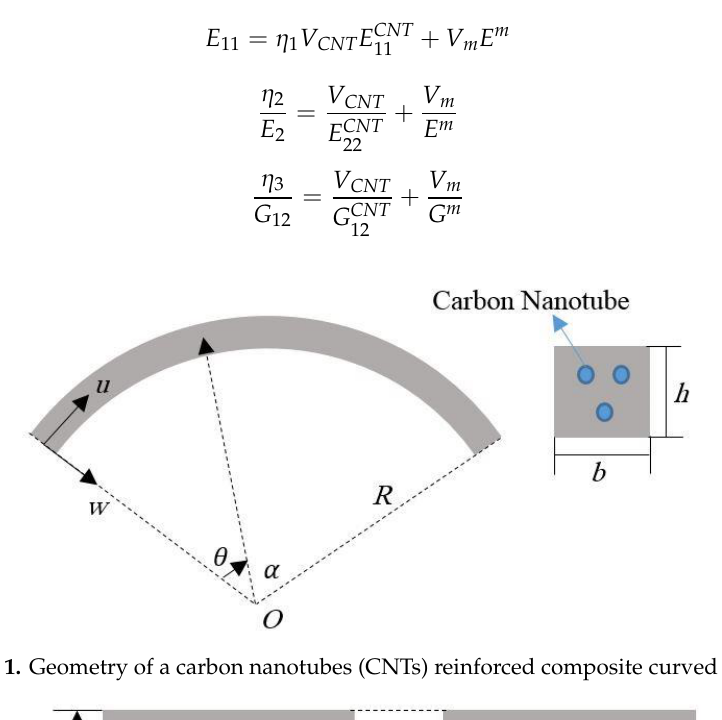
Figure 1. Geometry of a carbon nanotubes (CNTs) reinforced composite curved beam.